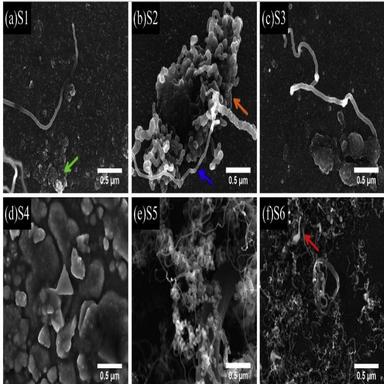
Different carbon nanostructures were grown alongside the reactor (S1eS6). (a) S1: Cu-NPs surrounded by graphite and graphite oxide as confirmed by XRD. (b) S2: short carbon nanofibers. (c) S3 showing the presence of Cu-NPs covered by graphite material and tubular carbon nanostructures. (d) S4: large Cu-NPs surrounded by graphite materials. (e) S5 showing the presence of helical carbon nanotubes and ultra-thin carbon nanotubes. (d) S6 exhibiting thin carbon nanotubes. (A colour version of this figure can be